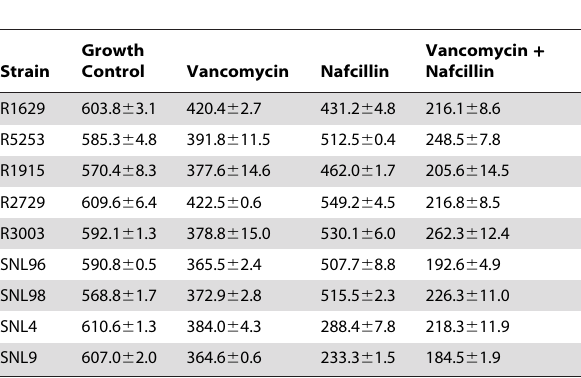
Table 1. Area under the bacterial kill curve values from the PK/PD